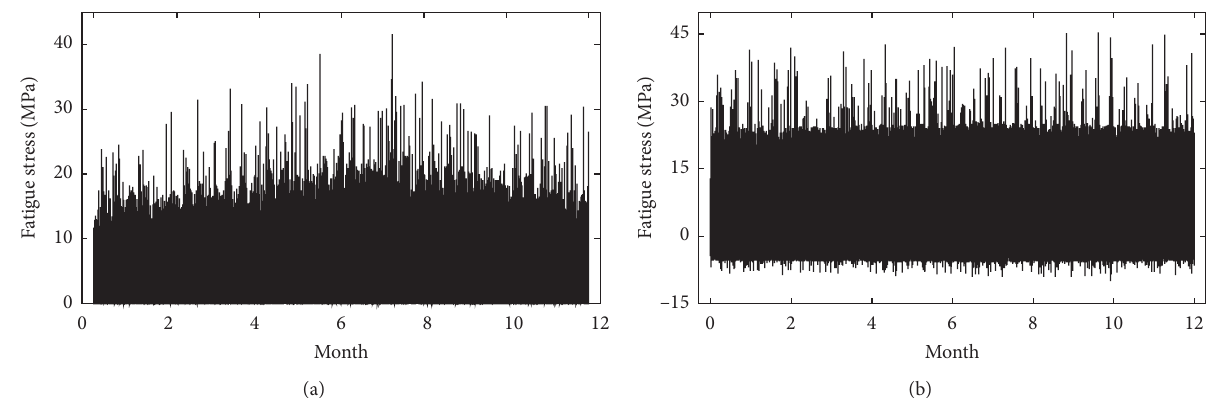
Figure 10: The fatigue stresses: (a) the rib-to-deck joint and (b) the rib-to-rib joint.